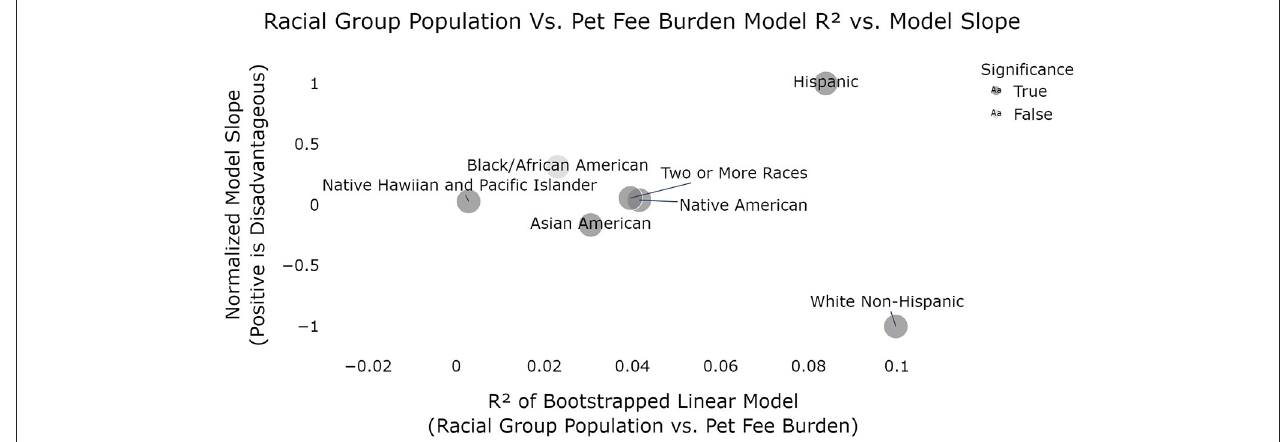
FIGURE 2 | Relationship between model slope of proportion of people of color vs. pet fee burden by racial/ethnic groups and model R 2 (dark gray is statistically significant models; p < 0.05). According to these models, White, Non-Hispanic populations are advantaged (in the form of lower pet fee burden) in relation to the racial makeup of their census tract while Hispanic/Latinx are the most disadvantaged. All models were significant except African Americans.